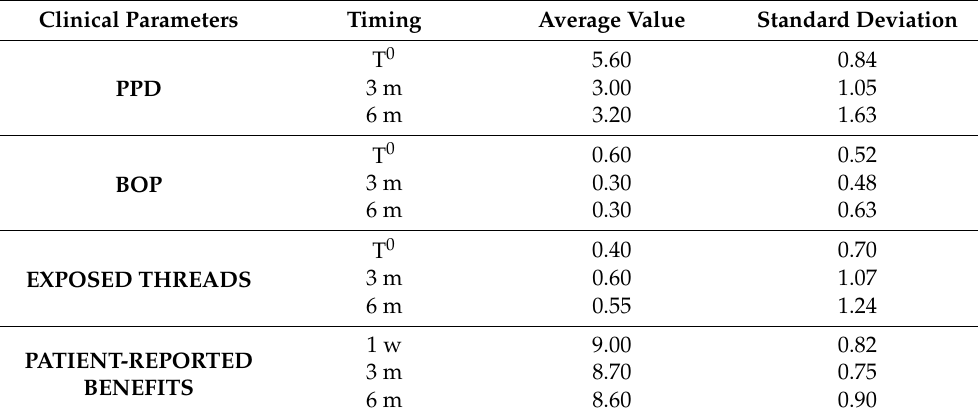
Table 2. Clinical parameters were measured at baseline (T 0 ), after 3 months, and after 6 months in peri-implantitis sites treated with Aladent ® . Clinical